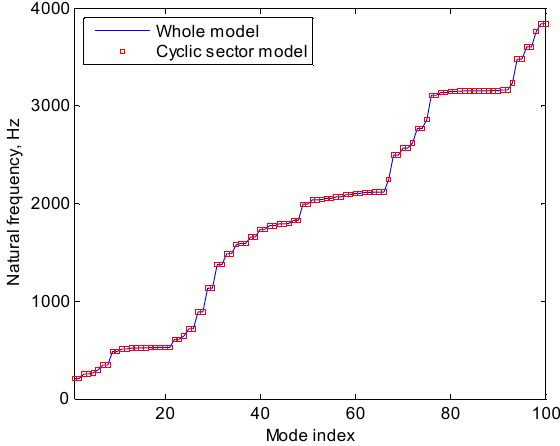
Figure 4. Comparisons on the first 100 natural frequencies of the tuned blade–disc–shaft assembly using the full ‐ order model and cyclic symmetry sector model.